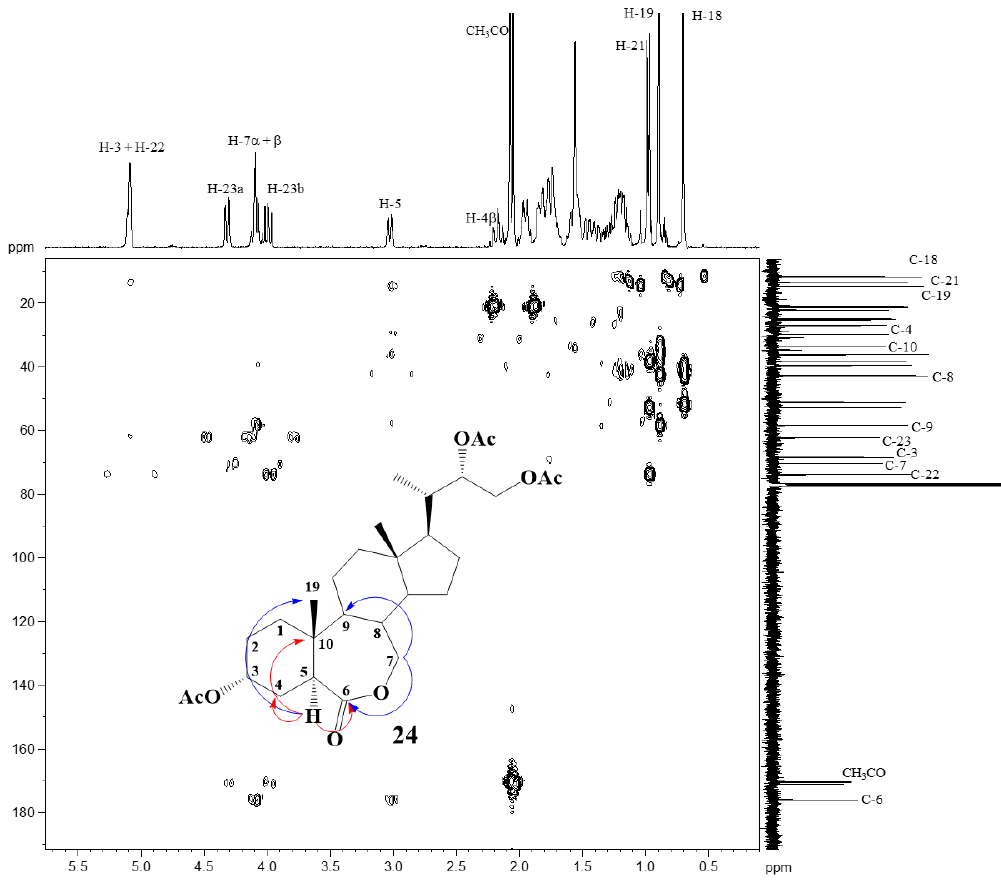
Figure 5. Inverse detection heteronuclear-correlated 2D 1 H- 13 C HMBC contour plot, and main 2 J HC (red) and 3 J HC (blue) correlations observed for hydrogens H-5α and H-7 of compound 24 (7-oxalactone).